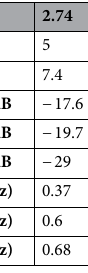
Table 4. Electrical properties of Antenna 4.